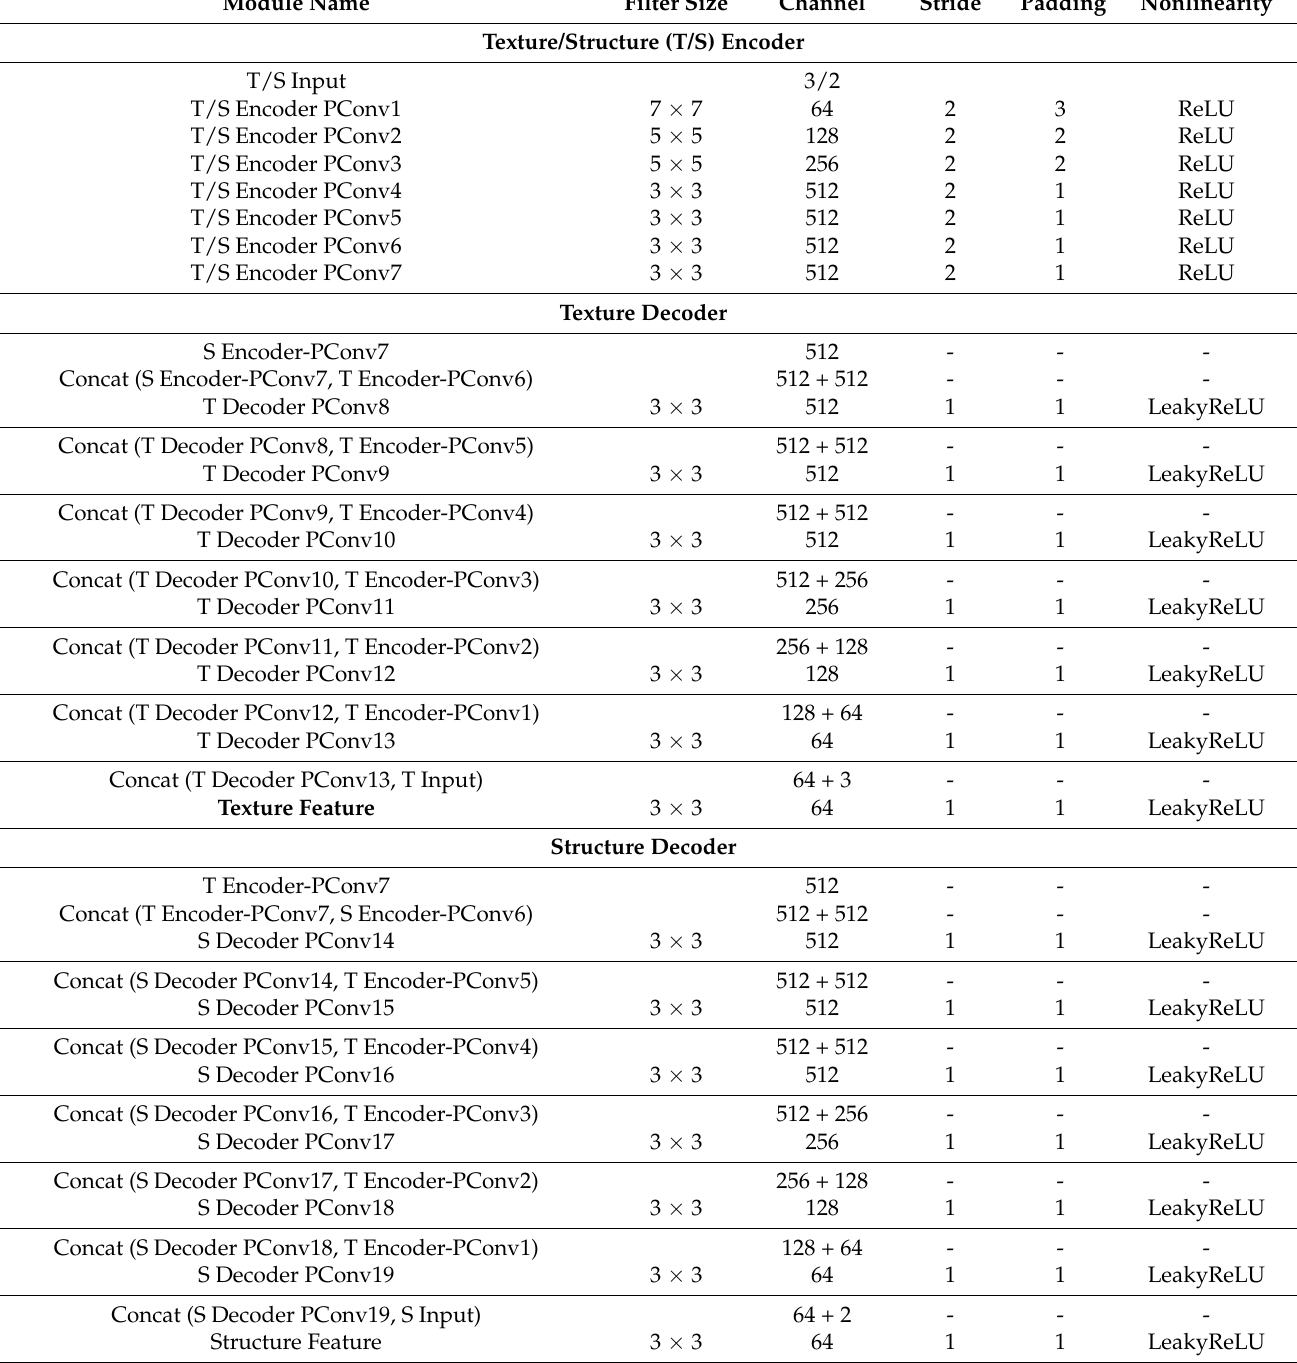
Table 1. Details of the texture and structure generator architecture. PConv is defined as a partial convolutional layer with the specified filter size, stride, and padding. Concat indicates that structure features and texture features are connected by a skip